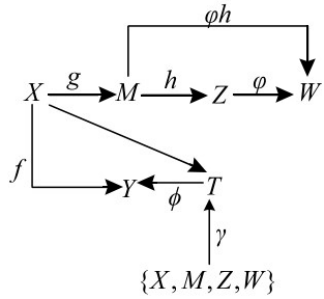
Fig. 8 Linear dimensionality reduction algorithm for the dimensionality reduction of